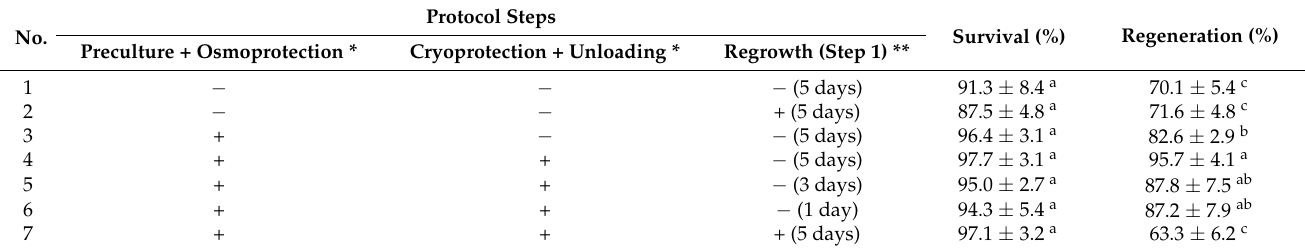
Table 1. Effect of presence (+) or exclusion ( − ) of ammonium nitrate at various steps of the droplet-vitrification procedure and in the regrowth medium on survival and regeneration of Pogostemon yatabeanus shoot tips. Shoot tips were cryoprotected but not